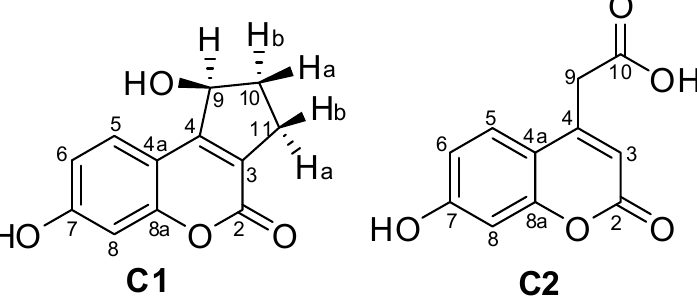
Figure 3. Chemical structures of C1 and C2 , which were isolated from the biotransformation of coumarins 4 and 7 , respectively.